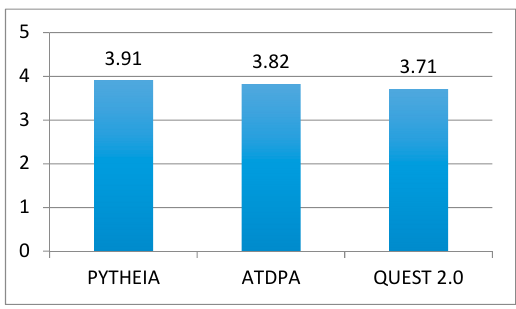
Figure 4. MOBOT mean score.